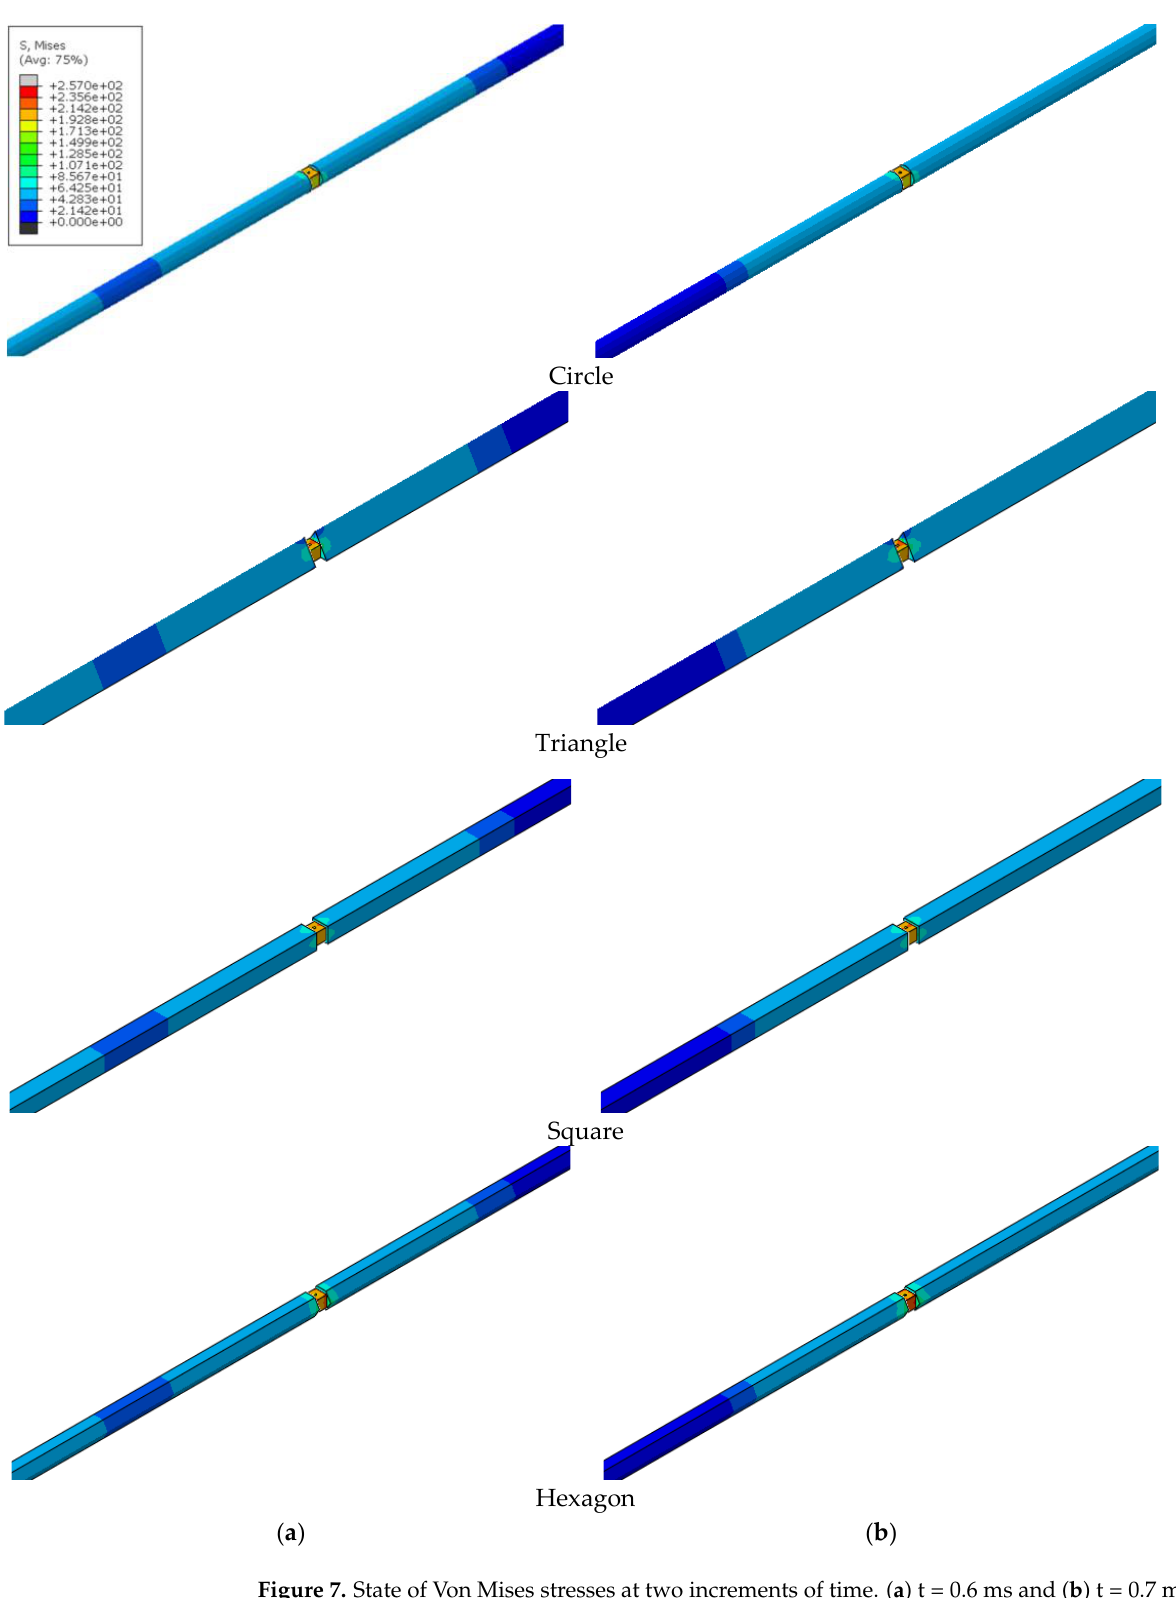
Figure 7. State of Von Mises stresses at two increments of time. ( a ) t = 0.6 ms and ( b ) t = 0.7 ms.